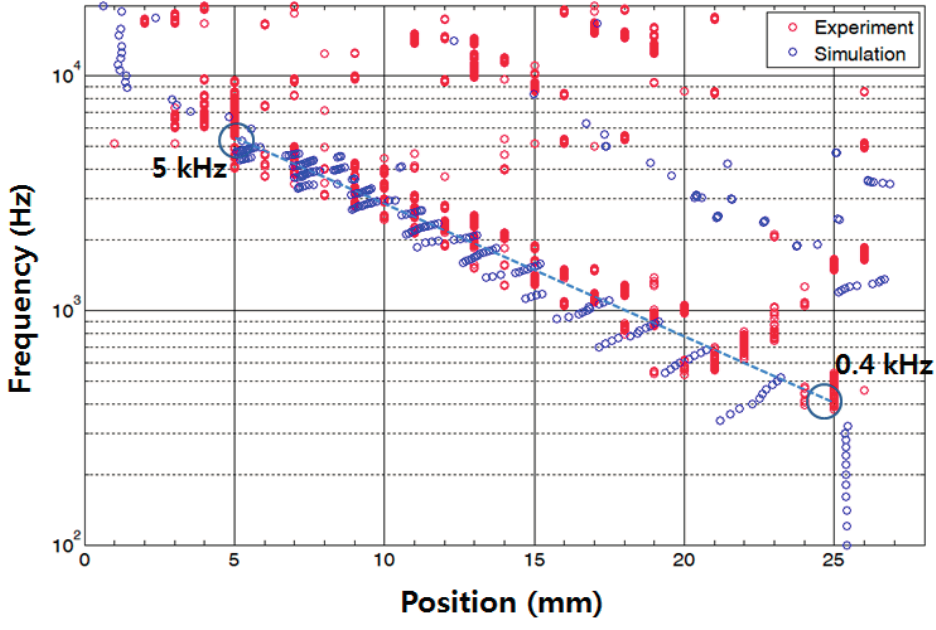
Figure 10. Frequency separation analysis of the designed PAC: each red (experiment) and blue (simulation) dot corresponds to the position having maximum displacement at each frequency expressed by the distance from the